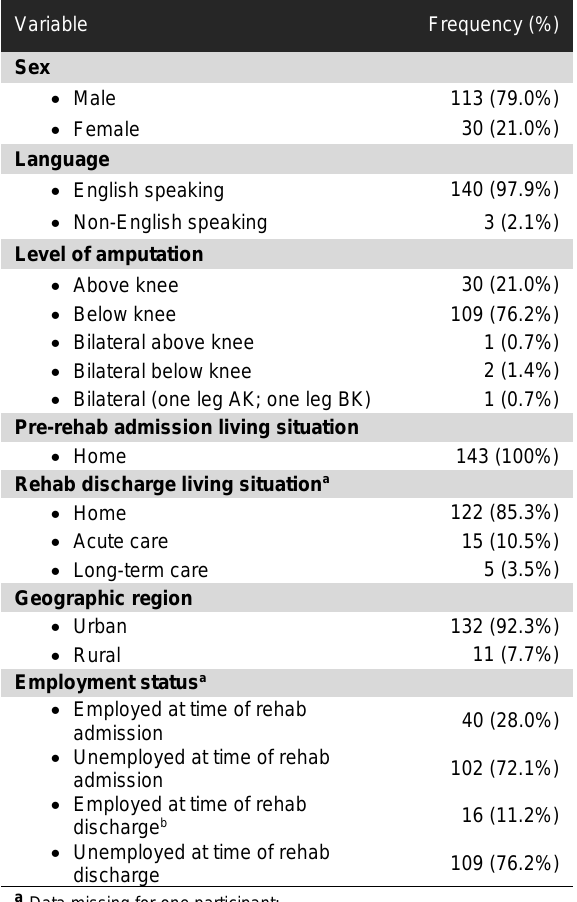
TABLE1: Sample demographic and impairment characteristics